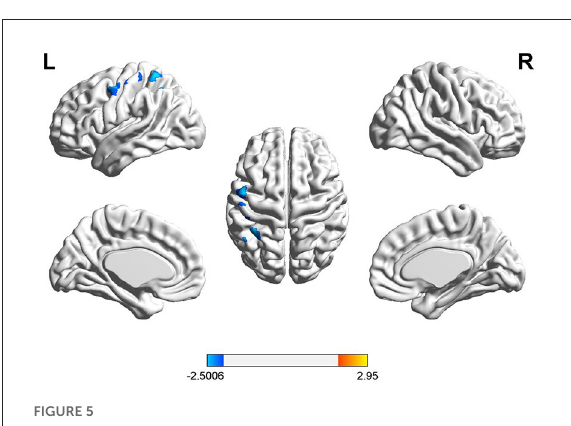
FIGURE5 Cortical activation associated with phrase repetition task. HbO activation maps between patients with global aphasia and healthy individuals, and the color bar represents the t -statistic. Cooler colors with negative values represent decreases in HbO in patients with global aphasia compared with healthy individuals ( p <